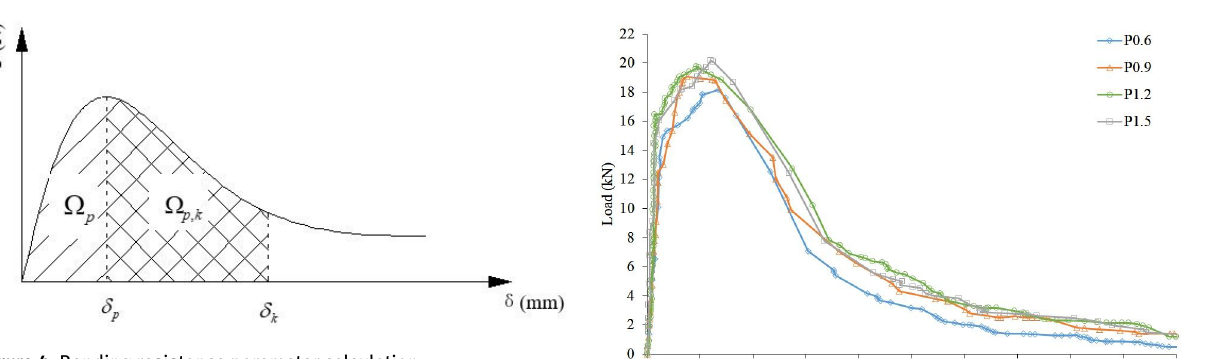
Figure 4: Bending resistance parameter calculation